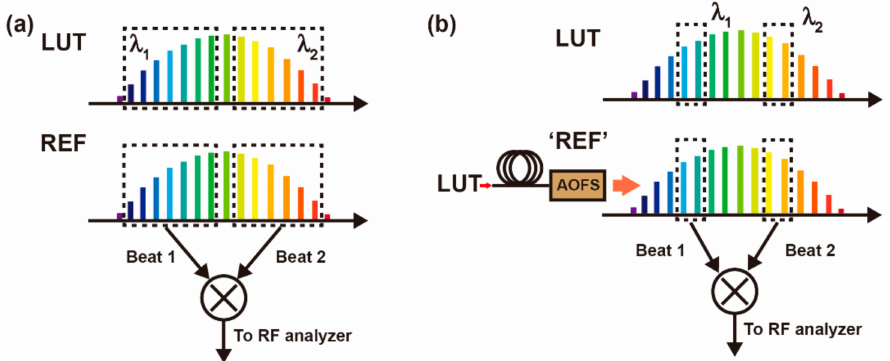
Figure 2. Experimental setup comparison of ( a ) OH technique and ( b ) DOH